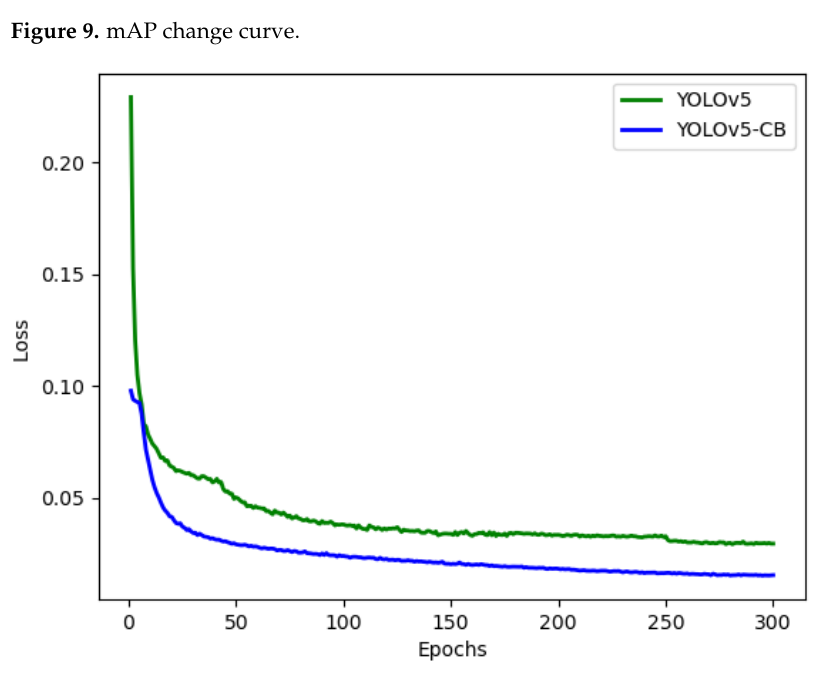
Figure 10. Loss curve. Table 6. Performance comparison of the different algorithm